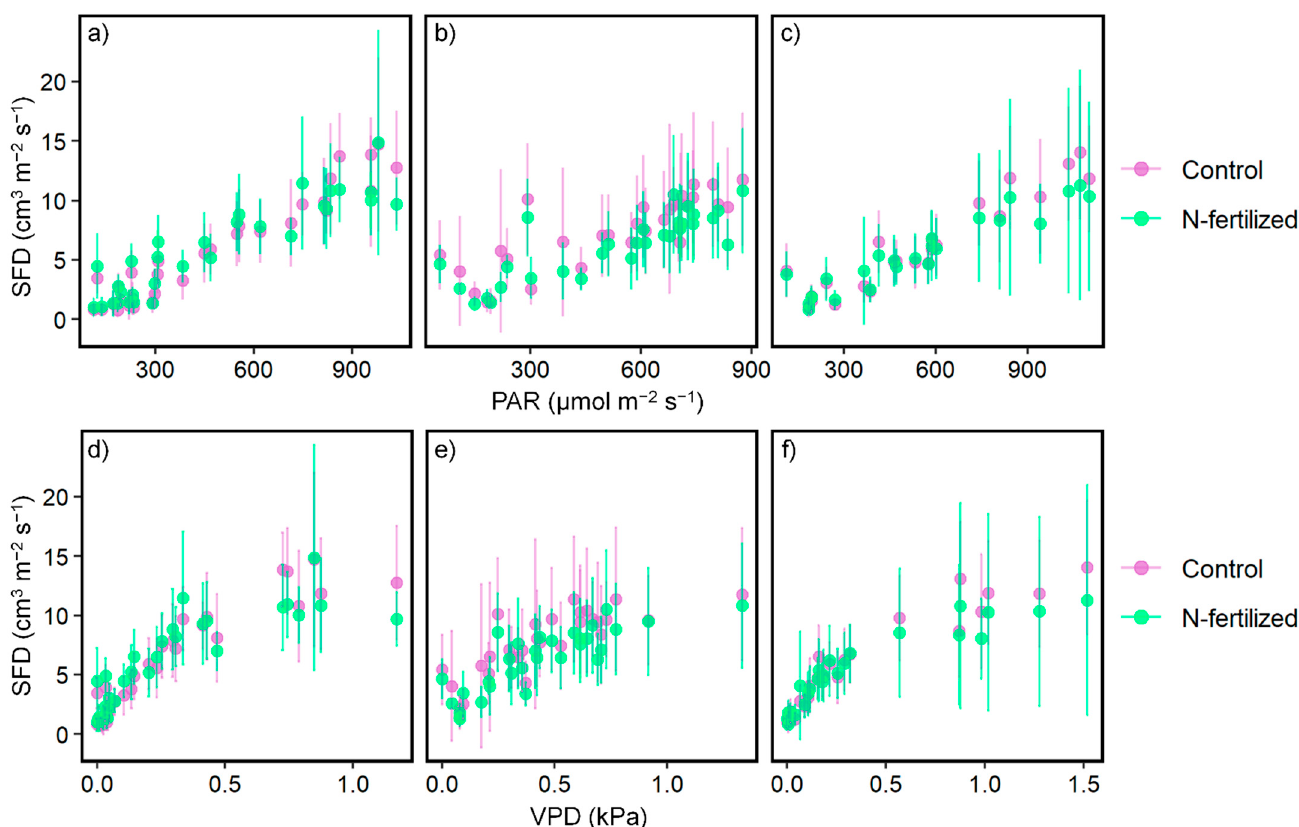
Figure 4. Comparison of the relationship between daytime mean sap flow density (SFD, n = 3–15) and meteorological conditions such as photosynthetic active radiation (PAR) and vapor pressure deficit (VPD) in three periods in 2019. Purple points indicate the data in the control plot, and green indicates the data in the N ‐ fertilized plot. ( a – c ) and ( d – f ) indicate SFD vs. PAR and SFD vs. VPD, respectively. ( a , d ), ( b , e ), and ( c , f ) indicate the data before fertilization from 3 July 2019 to 5 August 2019, 1st month after fertilization from 6 August 2019 to 5 September 2019, and 2nd month after fertilization from 6 September 2019 to 6 October 2019. Error bars are the standard deviation of SFDs in individual trees ( n = 3–15). Table 4. Summary of ANCOVA to examine significant difference for the daytime mean sap flow density (SFD) vs. meteorological conditions such as photosynthesis active radiation (PAR) and va ‐ por pressure deficit (VPD) between the control and the N ‐ fertilized in Figure 4.